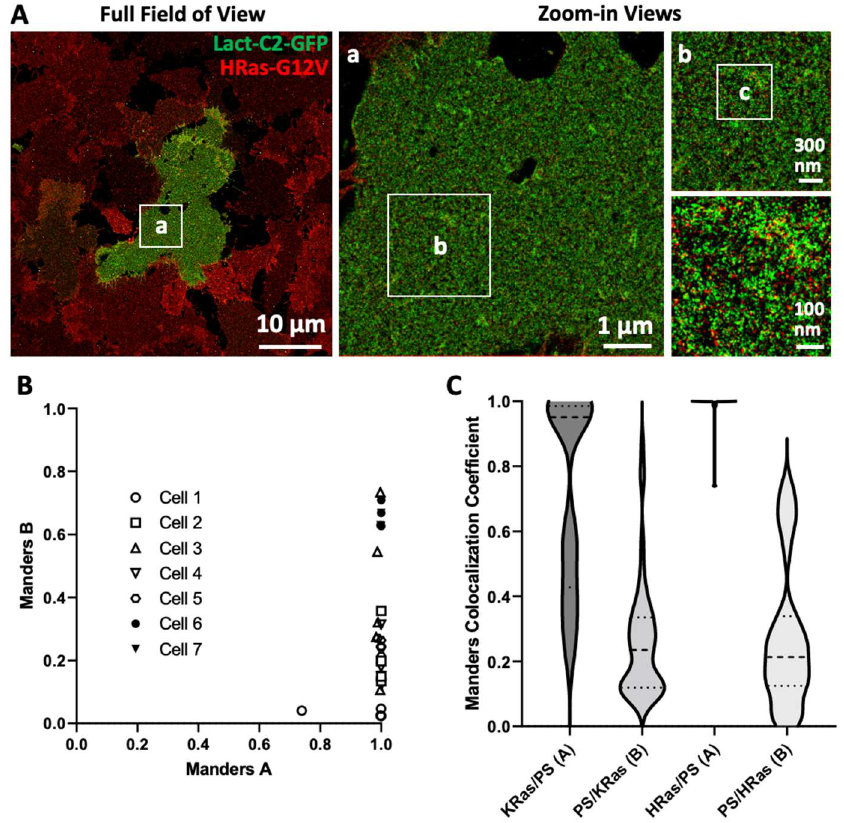
Figure 3. Dual color super resolution imaging of PS and HRas-G12V using exchange-PAINT and comparison of the spatial associations between PS and HRas-G12V or KRas-G12D. ( A ) Example dual-color DNA-PAINT image of transiently transfected Lact-C2-GFP (bound to PS) and stably expressed Halo-HRas-G12V in U2OS cells. Halo-HRas-G12V was imaged using a similar strategy to that for SNAP-KRas-G12D shown in Figure 2. Magnified views ( a – c ) show the molecular distributions of both targets. ( B ) Quantitation of Manders coefficients A vs. B based on the dual-color DNA-PAINT images. The experiment was performed in triplicate (N = 3) and included seven cells overall with 29 analyzed ROIs. ( C ) Violin plots of Manders coefficients for the associations of KRas-G12D or HRas-G12V with PS (A) and PS with either KRas-G12D or HRas-G12V (B). Experiments performed in triplicate (N = 3) including eight and seven cells for each KRas-G12D and HRas-G12V, with 55 and 29 analyzed ROI, respectively, were used for this graph.